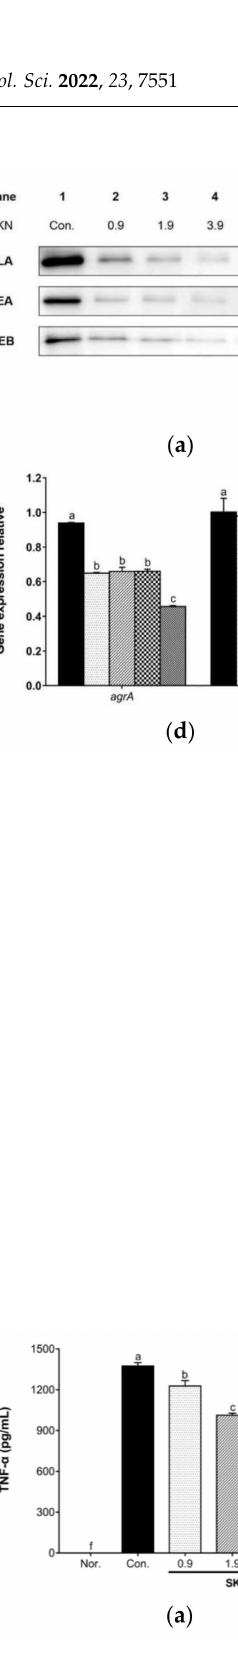
Figure 8. ELISA analysis of tumor necrosis factor α (TNF- α ) ( a ) and interleukin-6 (IL-6) ( b ) released by RAW 264.7 cells stimulated with the supernatants of MRSA DPS-1 grown in the presence of SKN. ( c ) The effect of SKN on the hemolytic activity of clinical MRSA strain DPS-1. The data are means ± SD of triplicate determinations. Different letters on the bars indicate significant statistical differences between treatments ( p < 0.05), while the same letters mean no significant differences ( p >